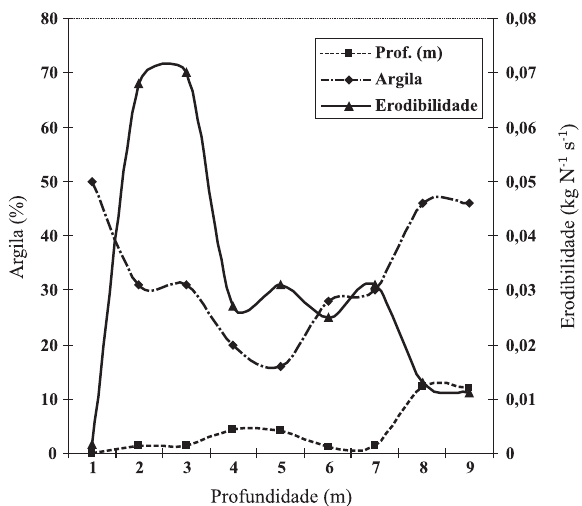
Figura 6. Erodibilidade e teores de argila em profundidade do Latossolo